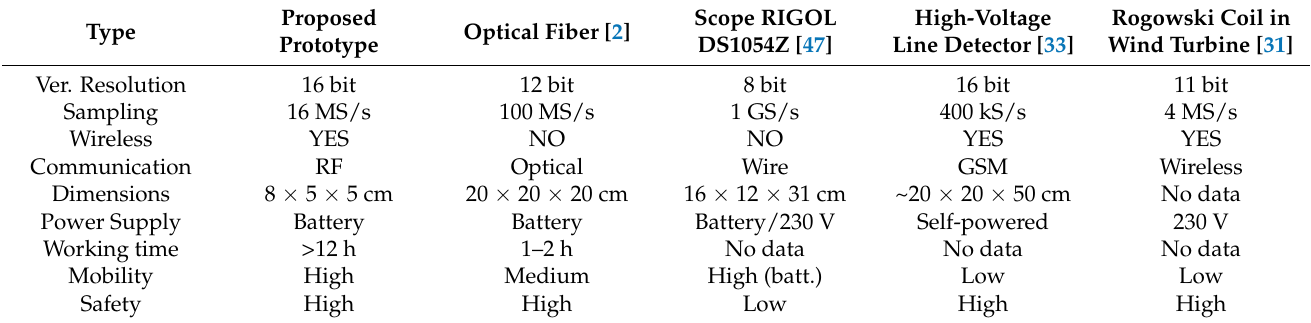
Table 1. Comparison of lightning measuring systems.